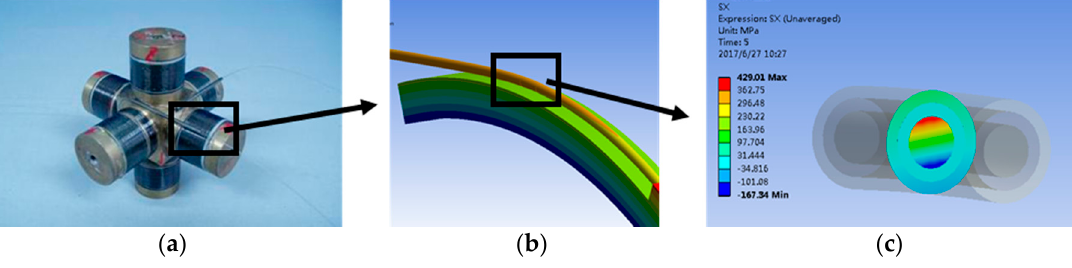
Figure 2. Twined optical fibers on the bobbin and partial views: ( a ) the optical fiber wound on the spool; ( b ) the partial view of the optical fiber subsection; ( c ) the cross-sectional stress of the optical fiber subsection.